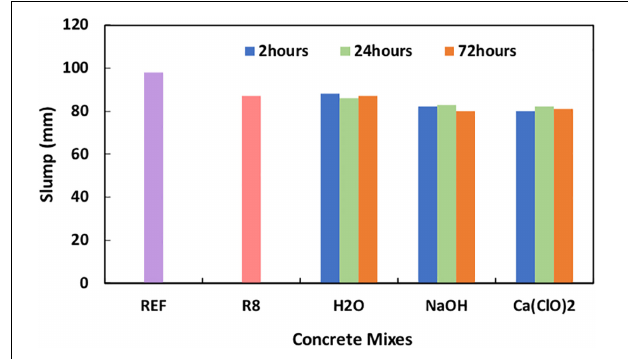
FIGURE 5 | Slump for reference and 8% rubber aggregates concrete mixes with and without treatment.